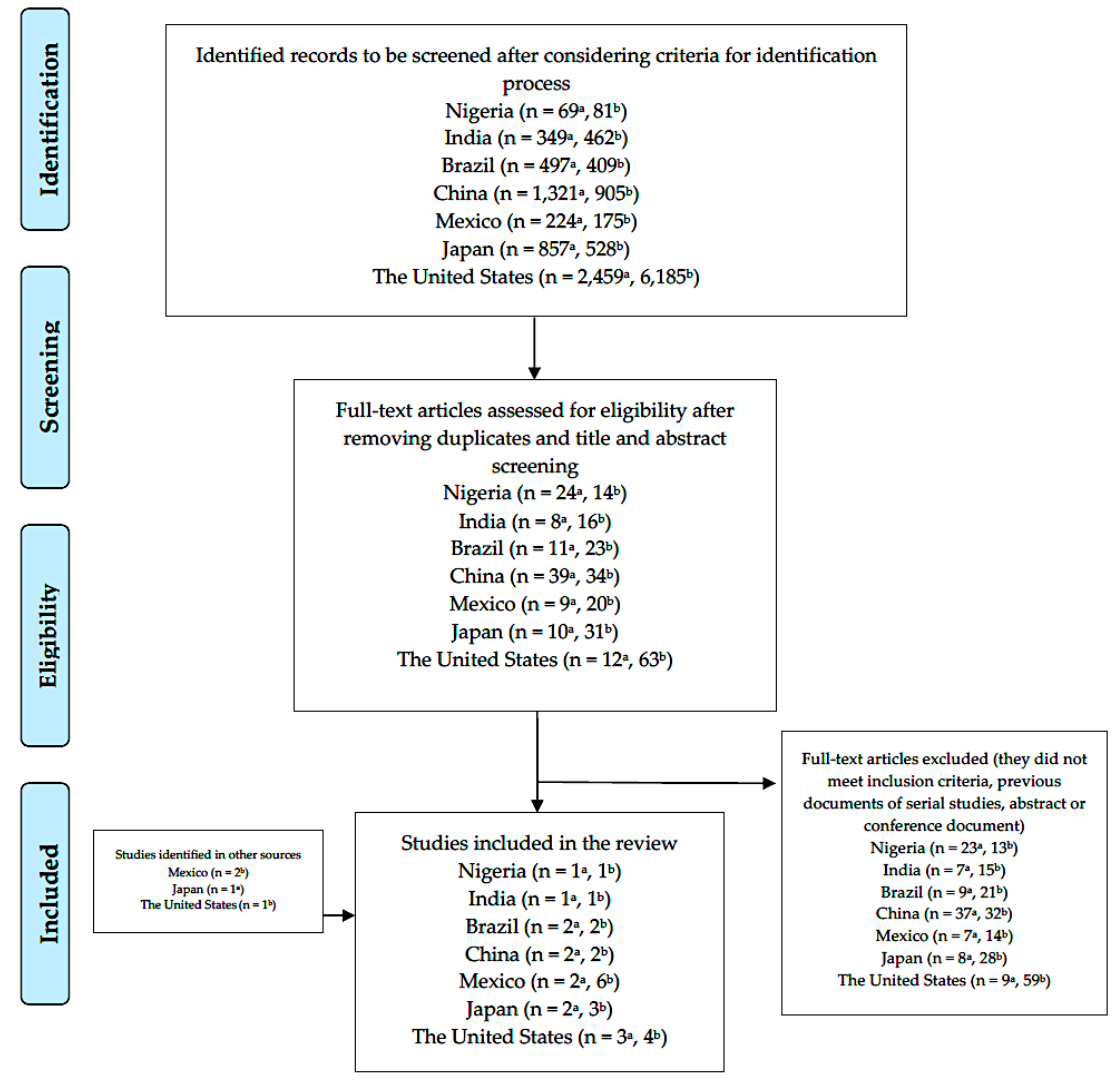
Figure 1. PRISMA flow diagram, literature review for seven mega-countries. a Search for dyslipidemias, b search for economic burden of cardiovascular diseases.